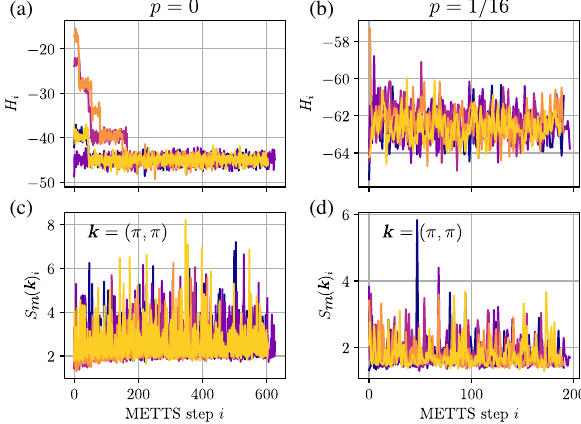
FIG. 15. Time series of energy and magnetic structure factor measurements from five different random initial states. Data shown for a 32 × 4 cylinder with parameters T=t ¼ 0 . 300 , U=t ¼ 10 . We use time-evolution parameters D and ε ¼ 10 − 6 and S x collapses. After initial thermalization, no autocorrelation effects are apparent. (a) Energy measurements at half filling p ¼ 0 . We observe several initial plateaus in the energy before thermalization. These plateaus are metastable states that correspond to antiferromagnetic domains. (b) Energy measurements at hole doping p ¼ 1 = 16 . (c),(d) Measurements of the magnetic structure factor S ð k Þ evaluated at ordering vector k ¼ ð π ; π Þ at p ¼ 0 and p ¼ 1 = 16 . We observe a skewed distribution, fast thermalization, and no apparent autocorrelation